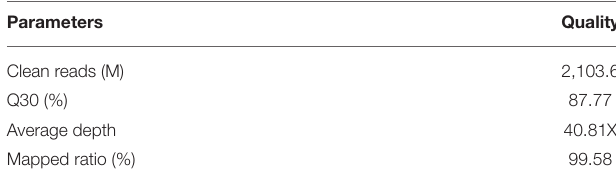
TABLE 2 | Summary of sequence data from next-generation sequencing (NGS).